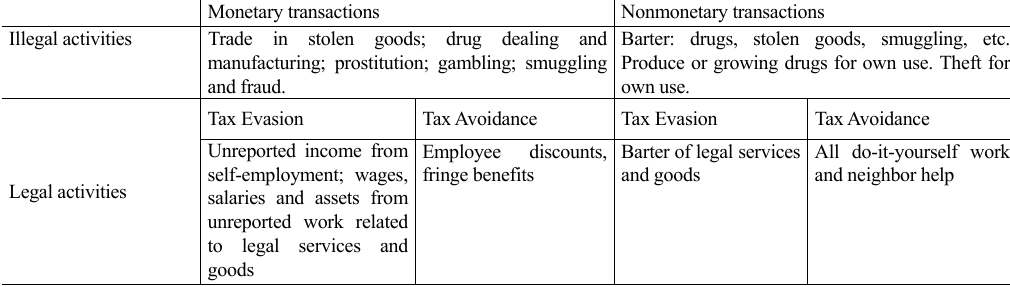
Table 1 : A Taxonomy of Underground Economic